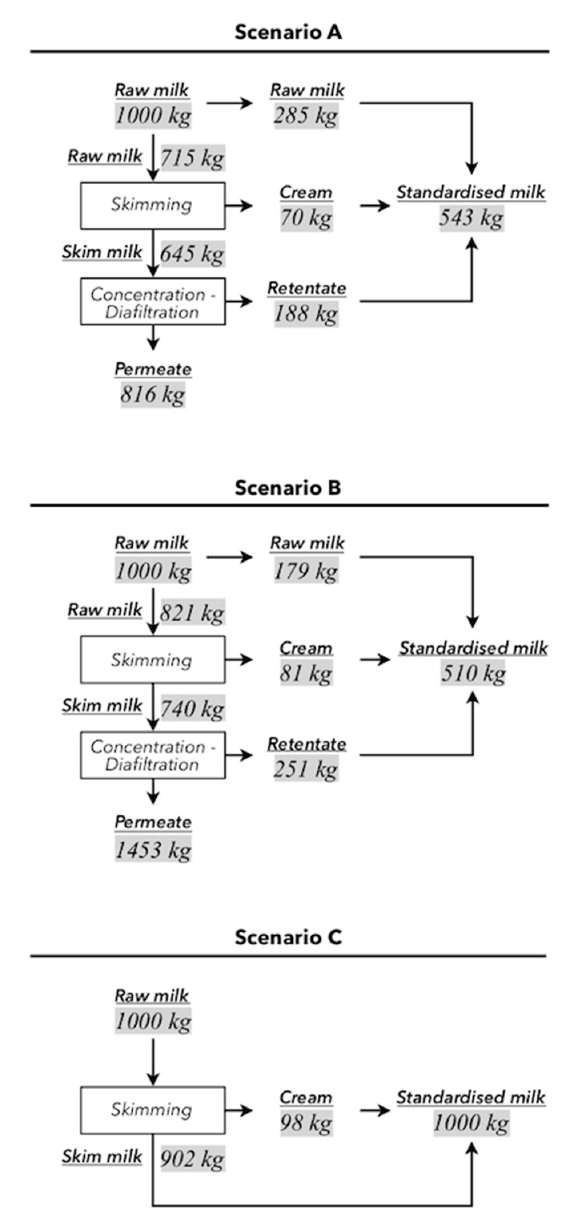
Figure 3. Distribution of the dairy fluids at the standardization step for scenarios A, B, and C.